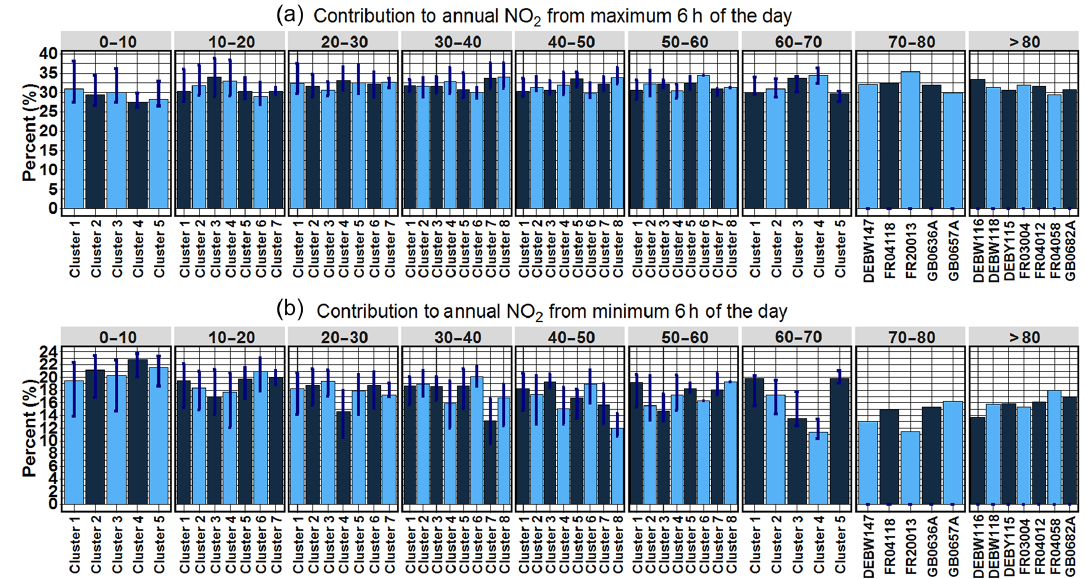
Figure 5. The contribution to 2010–2014 average annual NO 2 concentrations (NO 2AA ) from (a) the 6h with the largest contribution to 2010– 2014 NO 2AA , and (b) the 6h with the smallest contribution to 2010–2014 NO 2AA , for sites separated by 2010–2014 NO 2AA concentrations, and clusters demarcating distinct variation in monthly, hour of day, and hourly NO 2 concentration bin contributions to NO 2AA . These statistics are a proxy for variation in contribution to NO 2AA across the diurnal